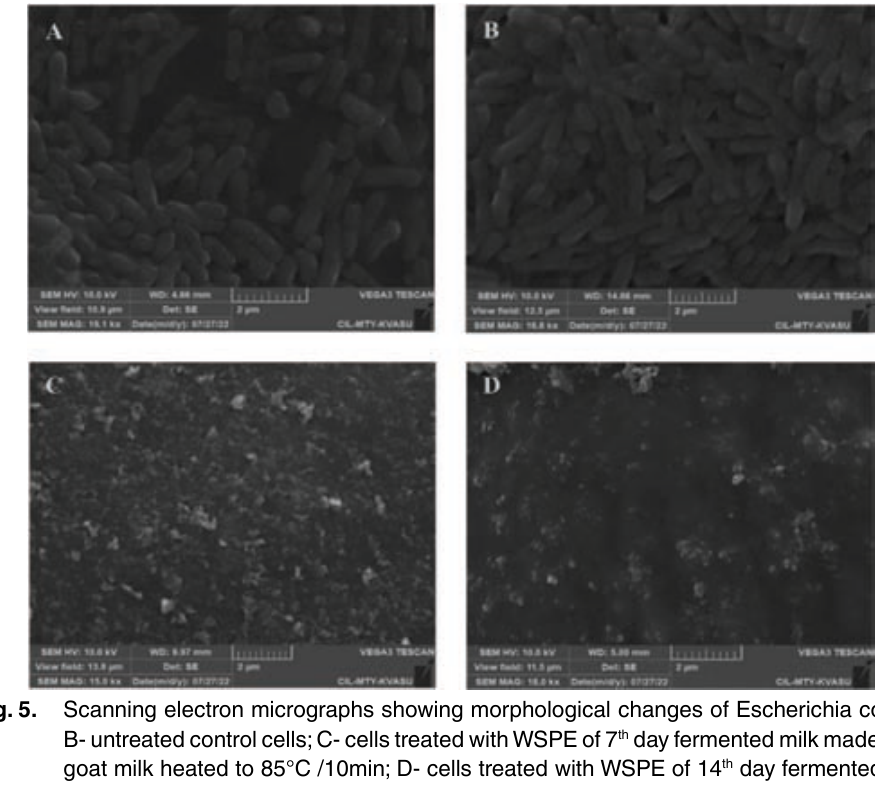
Fig. 5. Scanning electron micrographs showing morphological changes of Escherichia coli (A, B- untreated control cells; C- cells treated with WSPE of 7 th day fermented milk made from goat milk heated to 85°C /10min; D- cells treated with WSPE of 14 th day fermented milk made from goat milk heated to 85°C /10min) induced by treating for 6 hours at 37°C with